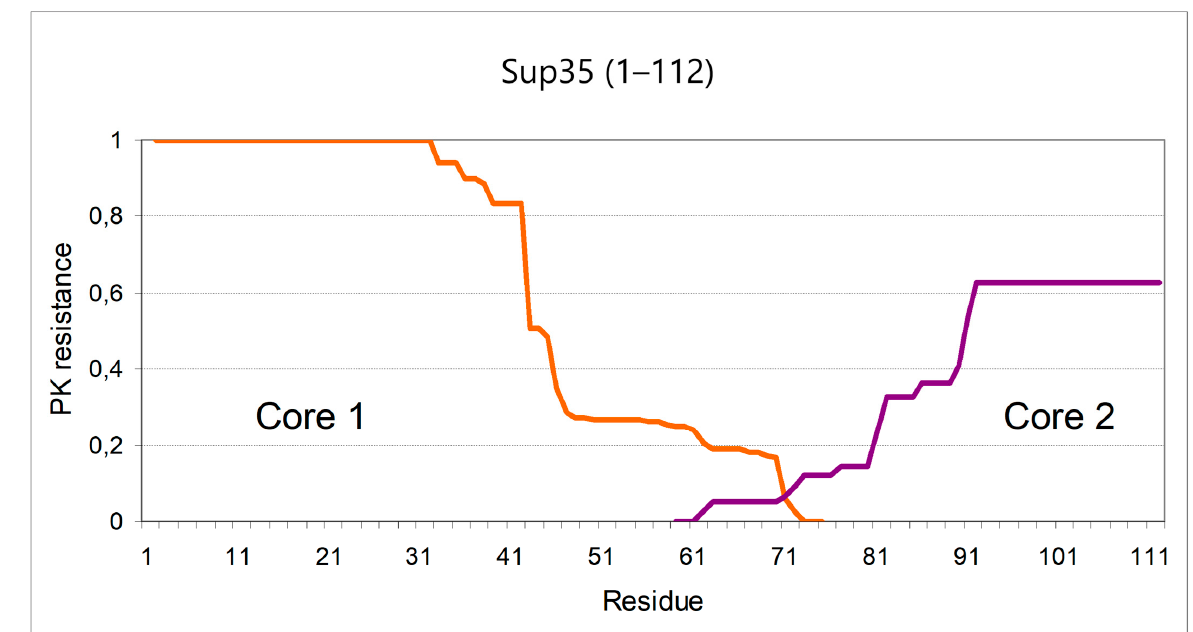
Figure 4. Proteinase K resistance profile of the Sup35(1–112) amyloid. The PK resistance index was calculated for every residue of Sup35NM as a sum of mass spectral peak areas of resistant peptides which include this residue [15]. The orange line sums the peptides starting from residue 2 (Core 1. First methionine is removed in yeast); purple line sums the peptides ending at residue 112 (Core 2). No other peptides were found. The terminal parts of the Core 1 and Core 2 are fully protected and therefore are equally resistant to PK. The difference in PK resistance values only reflects variation of the MALDI